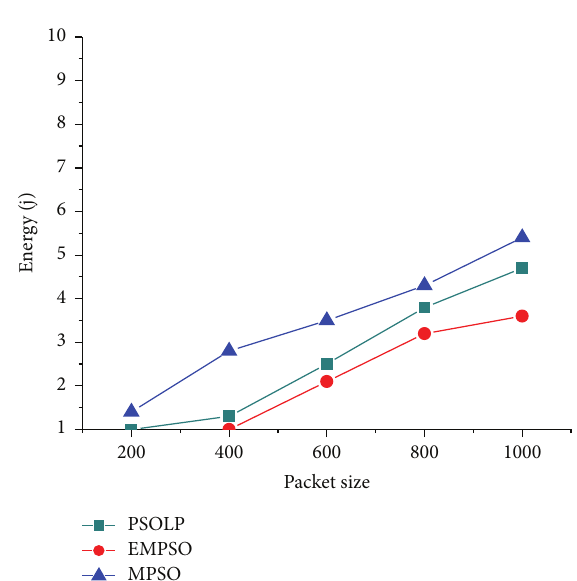
with PSOLP and MPSO; it reveals in reduced to generate control routing packets and hence alternate routing will be triggered. Therefore, the routing overhead is decreasing. In PSOLP and MPSO, the control packet flooded throughout the network until the destination was reached to find the loop-free routing. It caused the routing overhead. The routing overhead caused by EMPSO performs less than the other two protocols because of its PSO mechanism, a limited exchange of routing control messages among the nodes for the route discovery phase. EMPSO had a minimum routing overhead of approximately 43% when an optimal path of the nodes was selected.